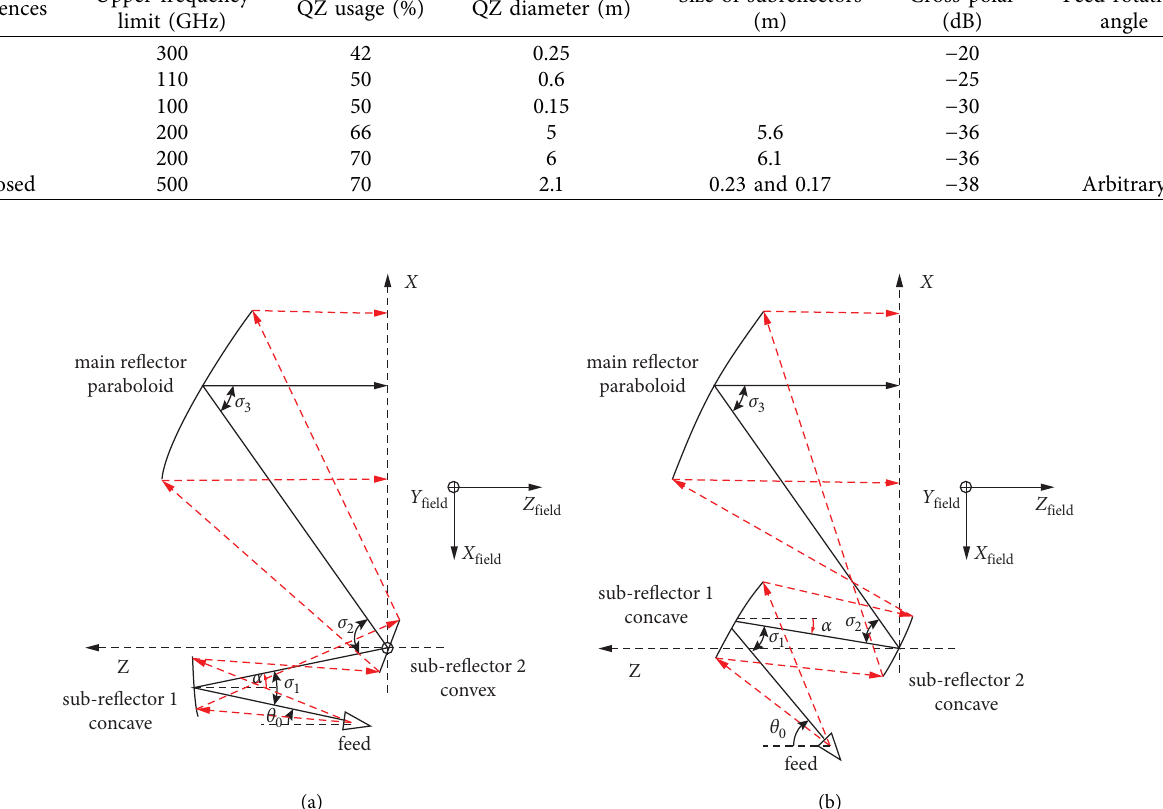
Figure 1: Specifc confguration forms of tri-refector CATR with low cross-polarization characteristics. (a) When α > 0 and (b) when α < 0.